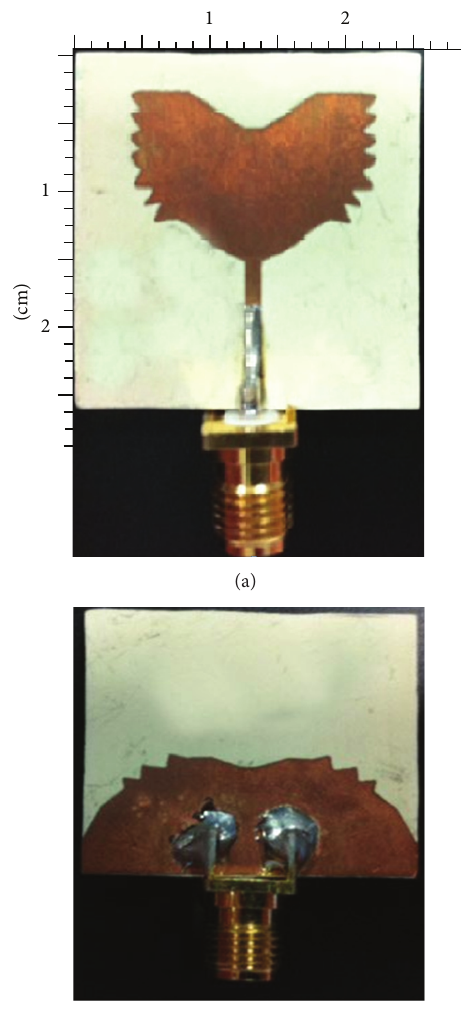
Figure 2: Fabricated prototype (radiating patch (a), ground plane (b)).